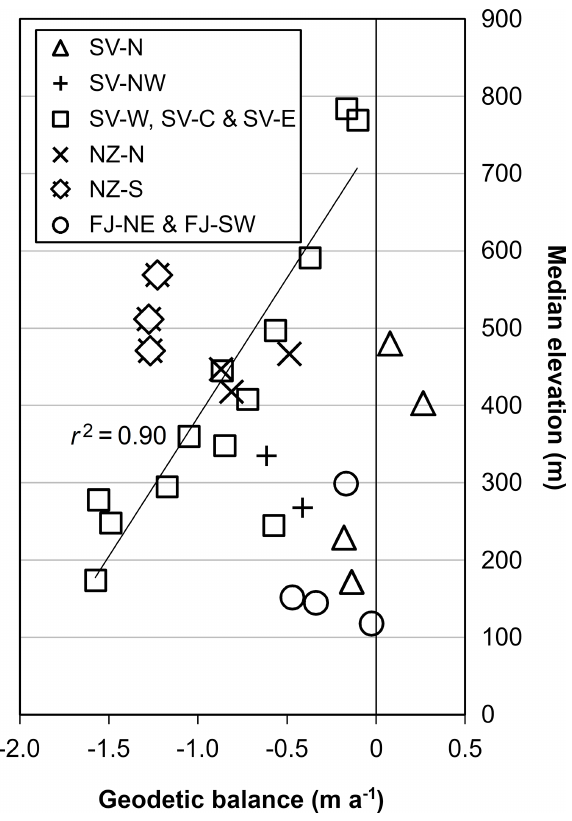
Figure 6. Relationships between site-wide geodetic balances of glaciers and their median elevations. The trend line and its squared correlation correspond to SV-W, SV-C, and SV-E, excluding a sin- gle outlier (Site